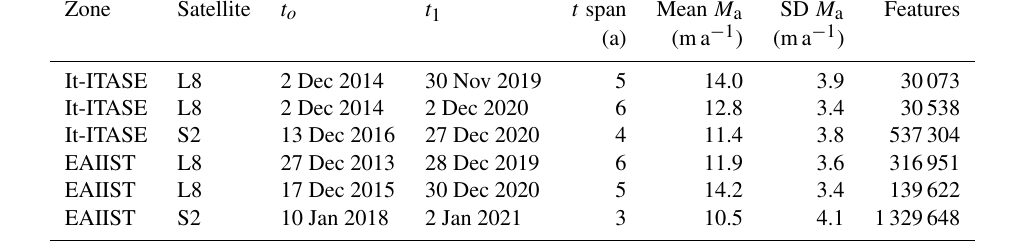
Table 1. Results of the absolute migration of megadunes calculated from IMCORR based on Landsat 8 OLI (L8), with a tile area of ∼ 38000km 2 , and Sentinel-2 (S2), with a tile area of ∼ 12000km 2 . Imagery at the It-ITASE and EAIIST sites.